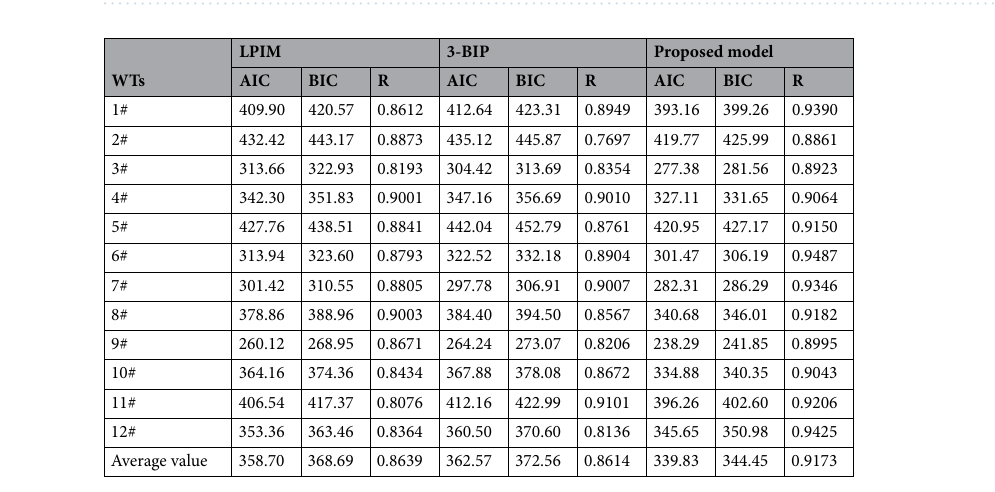
Table 2. Comparison of GOF results of different reliability